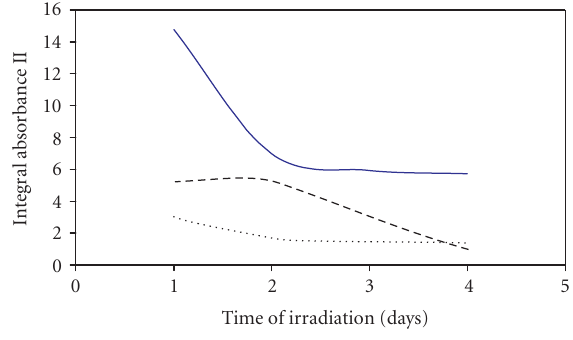
Figure 4: The changes of integral absorbance of Amide A band in FTIR spectra during solar irradiation of collagen (solid curve), col- lagen/PVA (dotted curve), and collagen/PVP films (dashed-dotted curve), key to time and dose of solar radiation in Table 1.